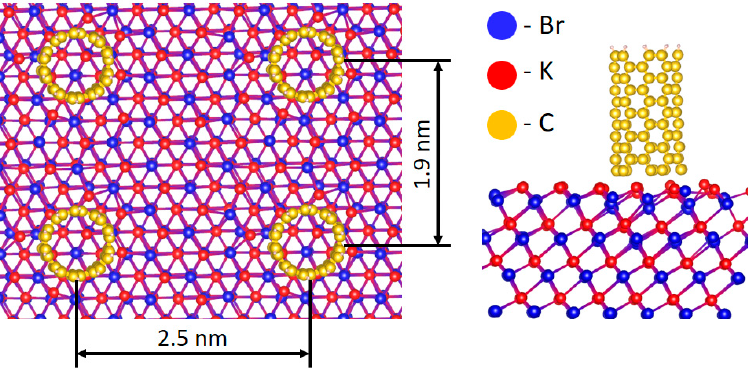
Figure 6. Atomic structure of the considered KBr/CNTs interfaces.